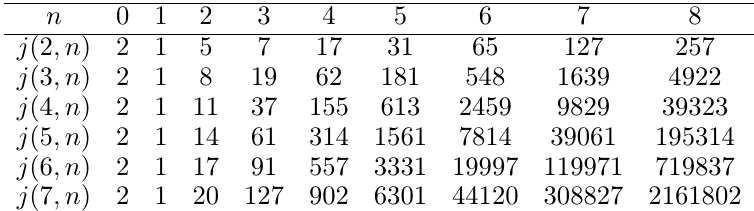
Table 2. The terms of { j ( k, n ) } for 2 ≤ k ≤ 7 and n ≤ 8